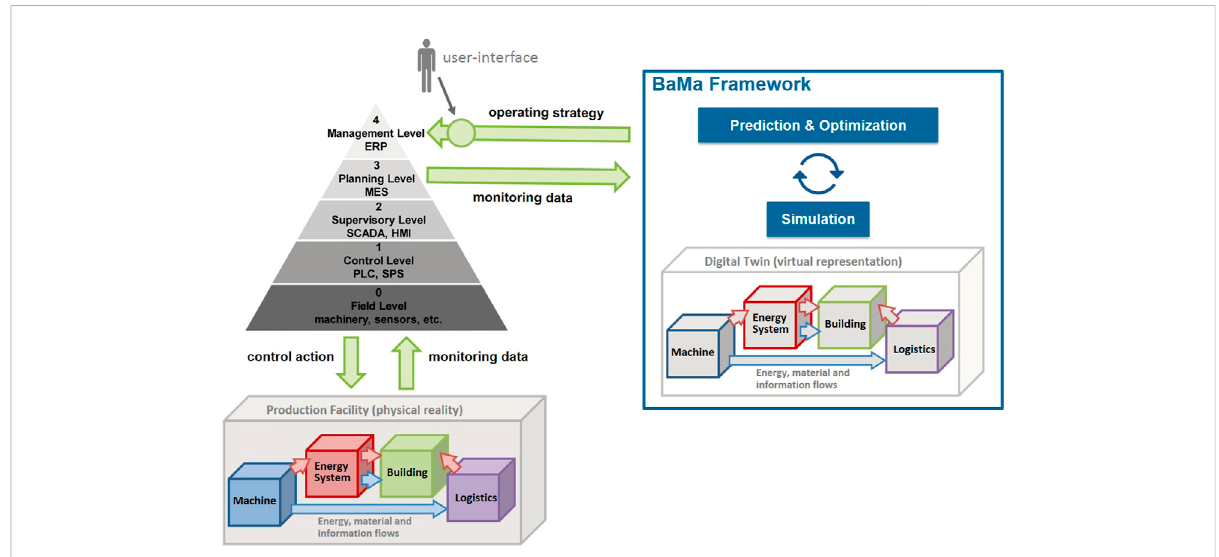
FIGURE 2 Schematic representation of the BaMa framework ’ s components and interconnectivity (adapted from BaMa,